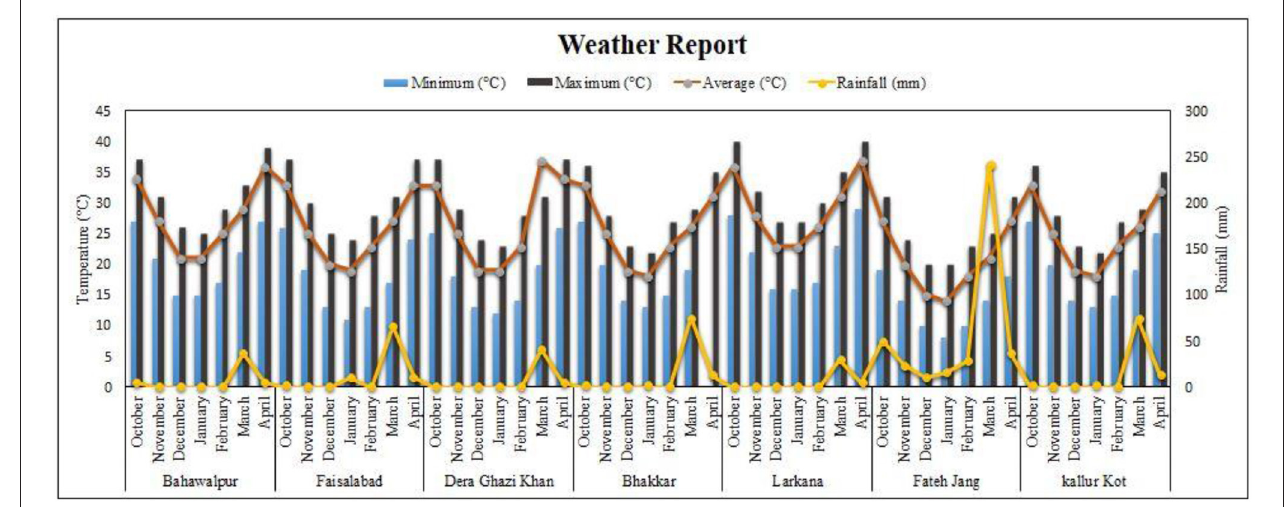
FIGURE 2 | Description of weather Conditions for all locations (year